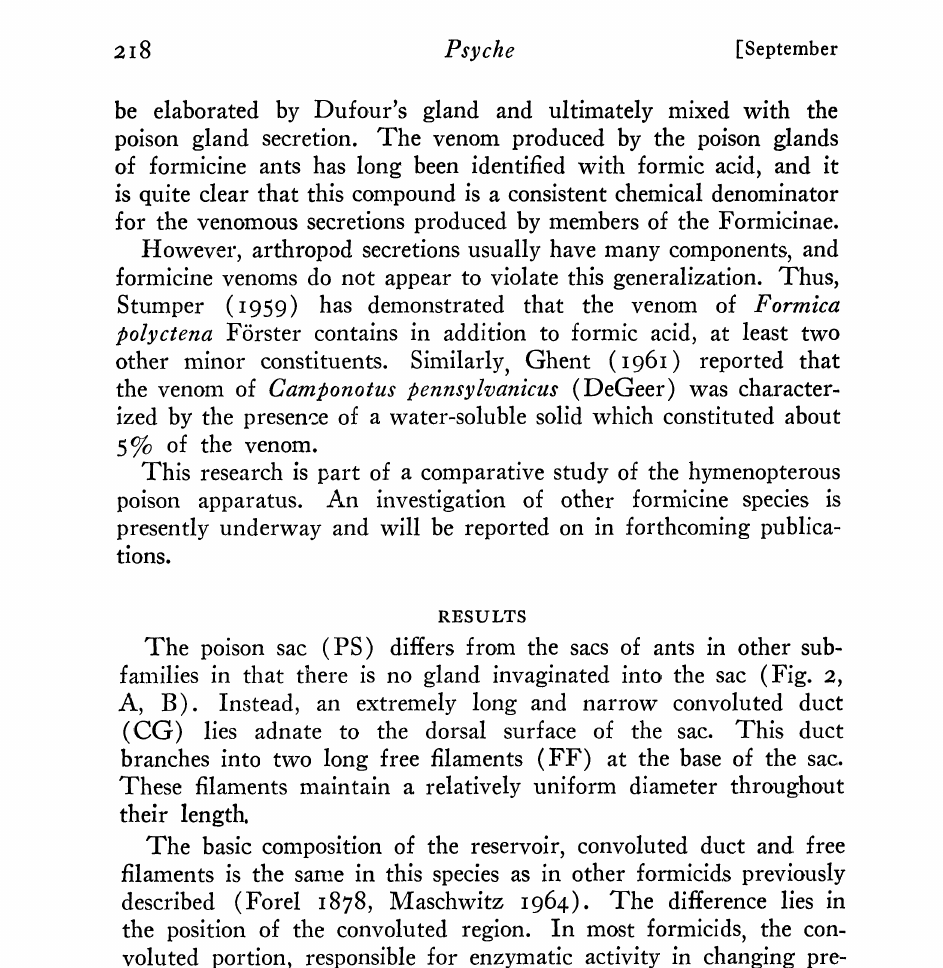
Fig. 1. Comparison between the poison apparatus of Camponotus penn- syl,vanicus and what may be considered a typical stinging ant. A-Apparatus similar to that found in ponerine ants (LV). B-Transverse section through sting of a stinging ant species. C-Distal tip of sting showing barbed lancet tips extending posteriad from tip of sting shaft (LV). D-Poison apparatus of C. pennsylanicus